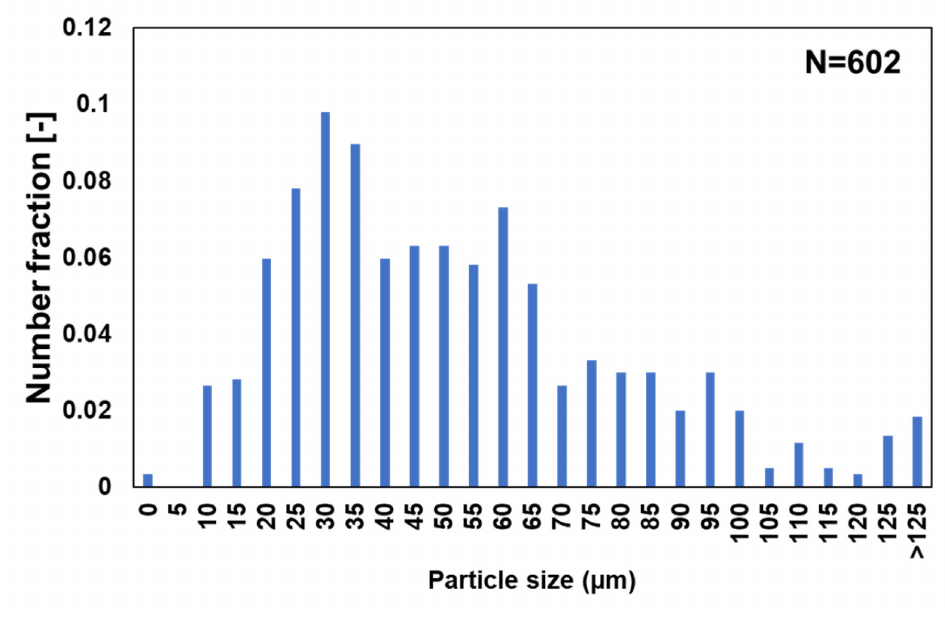
Figure A5. Particle size distribution of PEGMA gel beads.